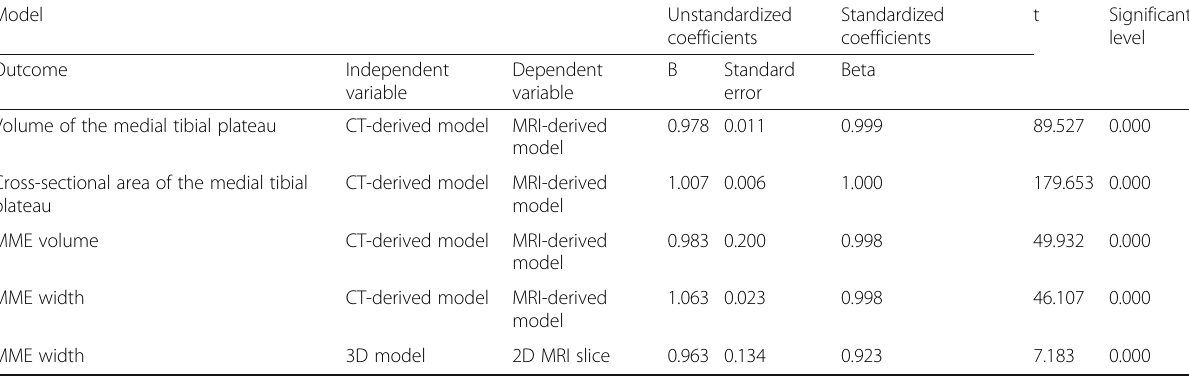
Table 4 Models of linears regression analyses and results of each analysis